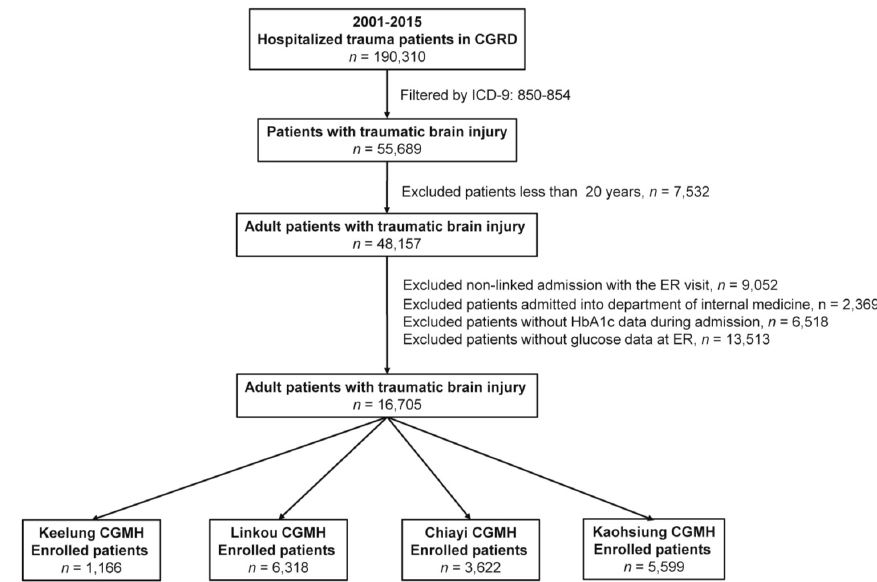
Figure 1. Flow chart illustrating the inclusion and exclusion of adult patients with Table 2.